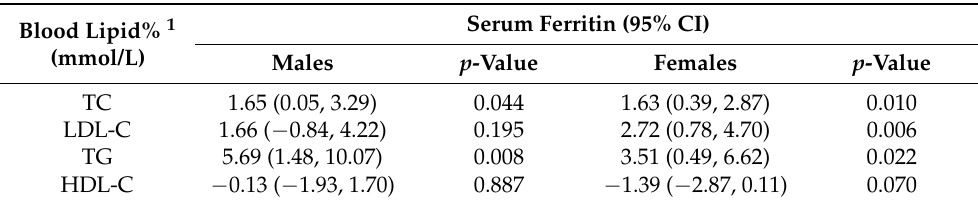
Table 2. Adjusted percent difference (%) and 95% CI in serum ferritin measures in relation to lipid